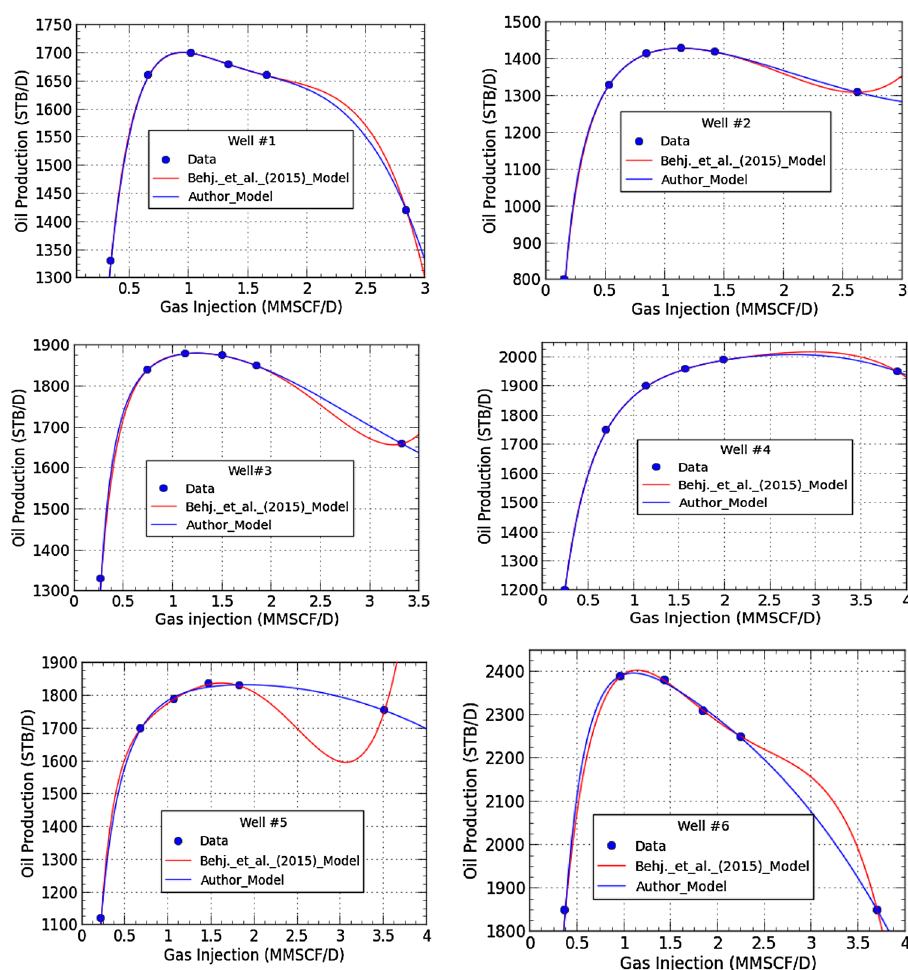
Fig. 4 Comparison of opera- tional data fitting for wells studied by Kanu et al. (1981) using the author’s model and the Behjoomanesh et